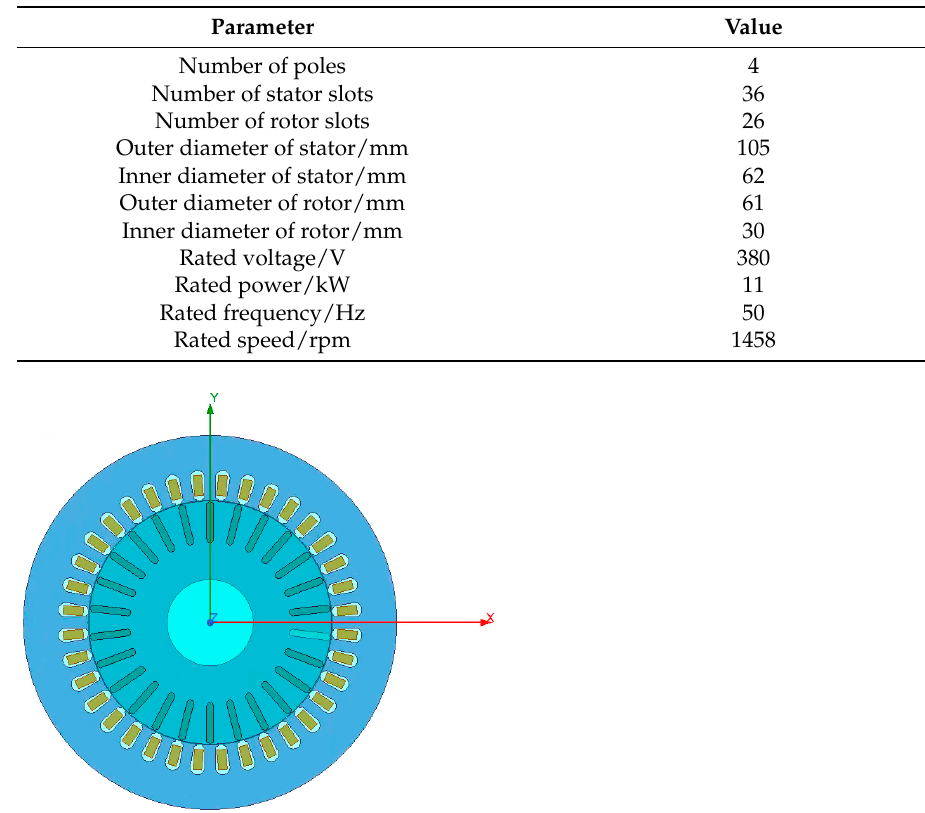
Table 1. The parameters of motor.